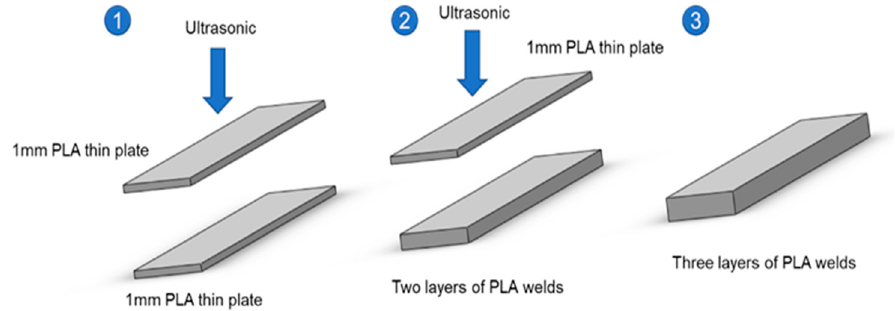
Figure 4. Schematic diagram of PLA ultrasonic welding forming process .